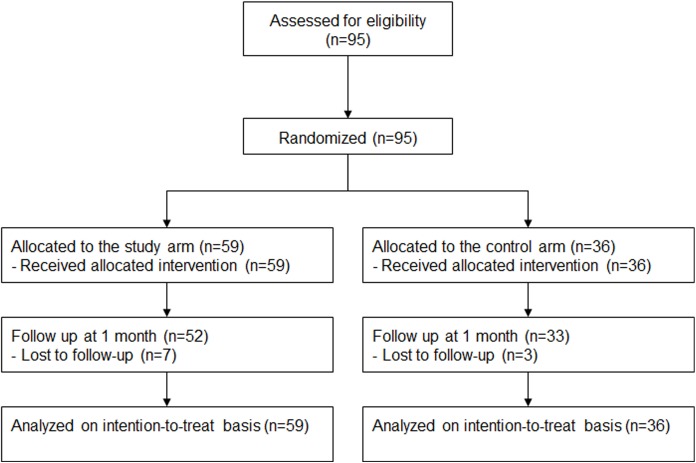
CONSORT flow chart of the study.